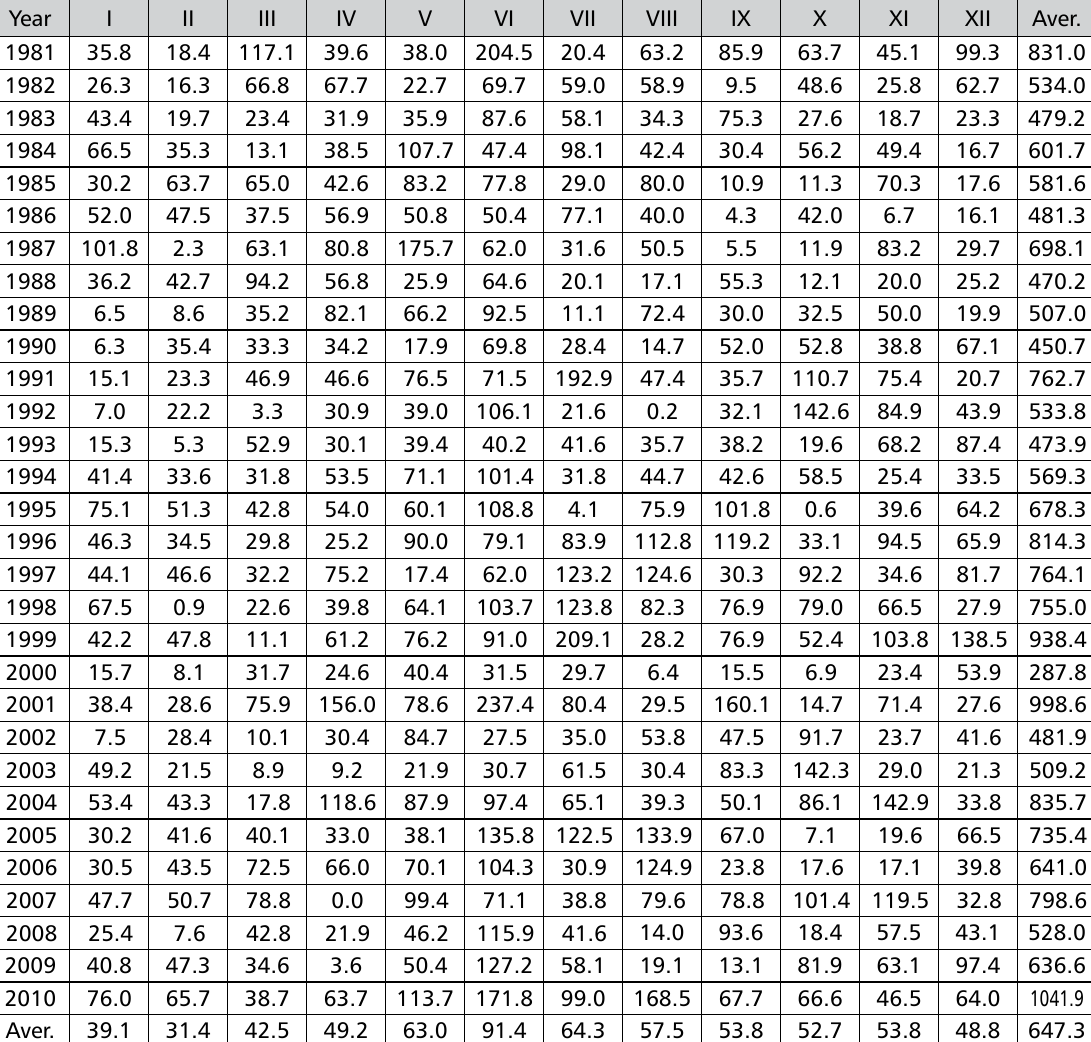
Monthly and annual sums of precipitation in Bačka palanka area (mm), over the period